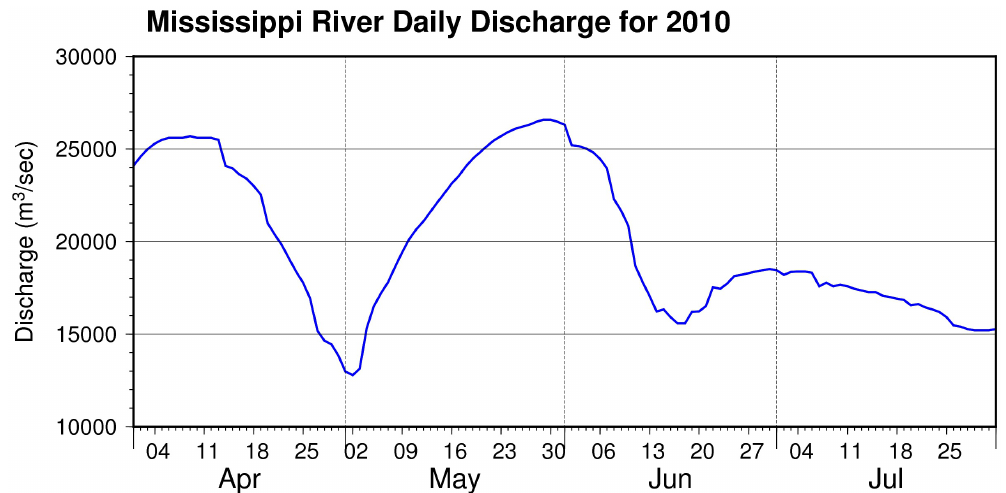
Figure 3. Discharge from Mississippi River in the Northern Gulf of Mexico during late spring and early summer 2010. Data kindly provided by U.S. Army Corps of